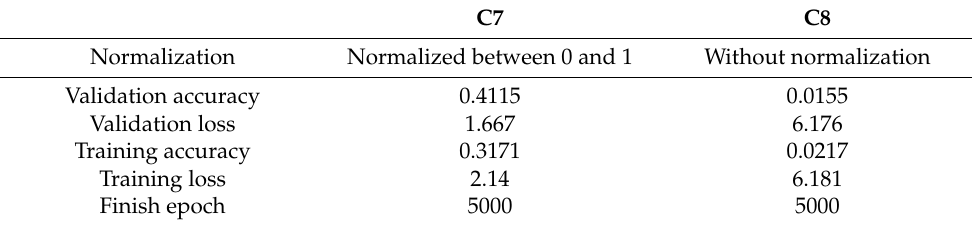
Table 4. Dataset normalization results.